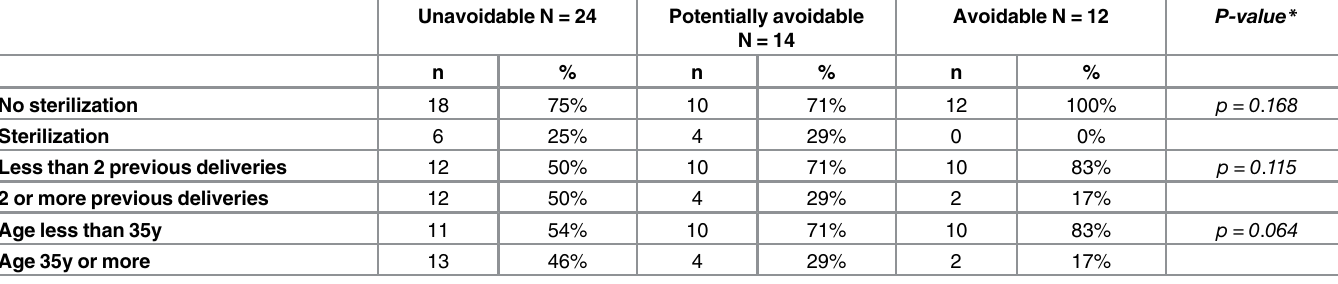
Table 5. Sterilization, parity and maternal age as predictors for